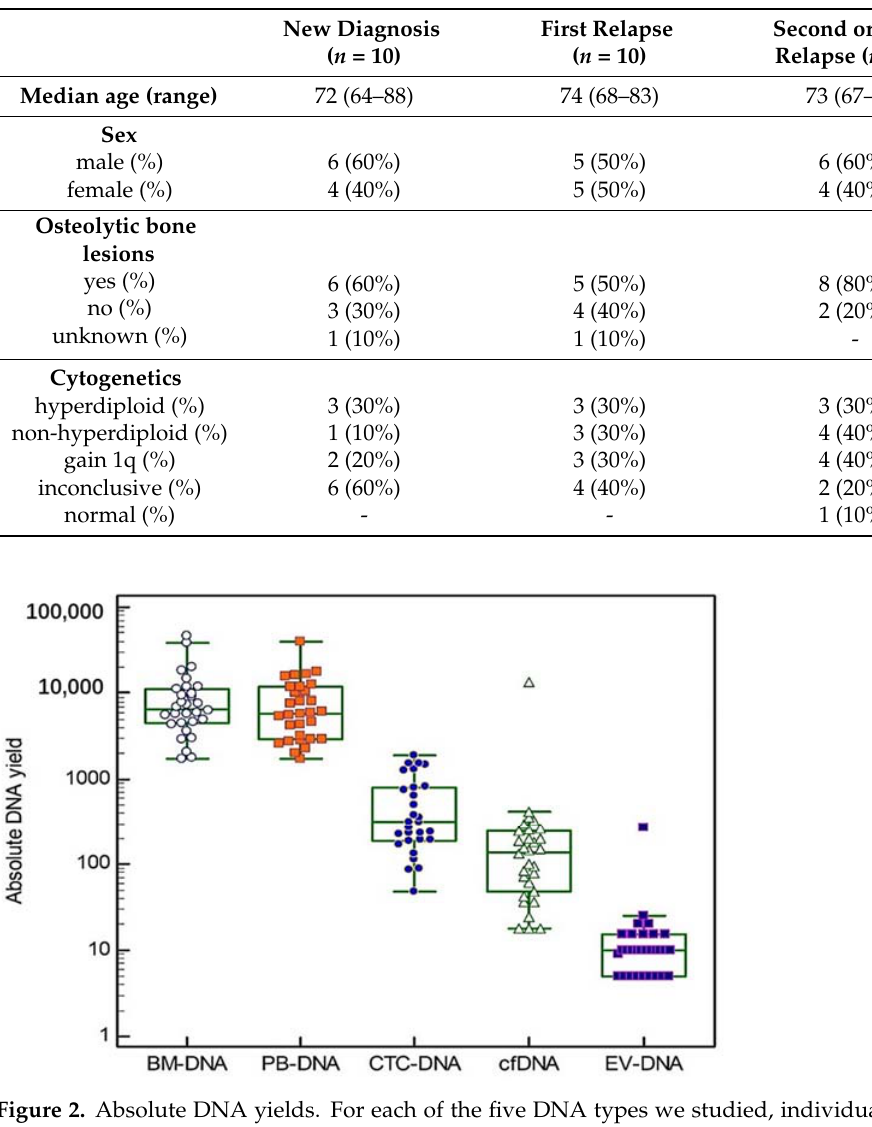
Figure 2. Absolute DNA yields. For each of the five DNA types we studied, individual absolute DNA yields are shown on a logarithmic scale. The central box in the boxplot indicates the values between the 25th and 75th percentile, while the line within the box represents the median. Outliers are shown as separate points above the upper limit of the boxplot.